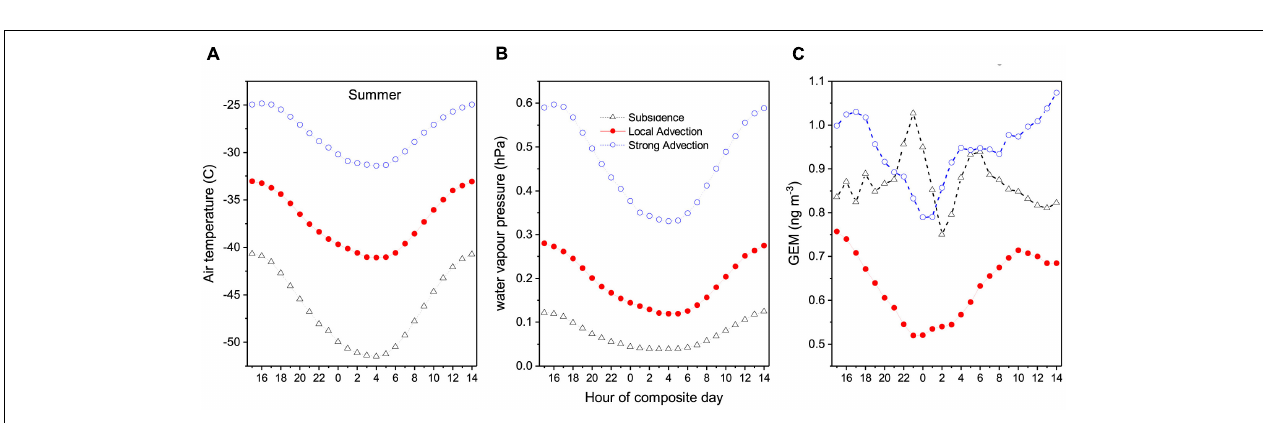
FIGURE 15 | (A,B) Summer diurnal composite distributions of hourly temperature and radon at DC for the three fetch classes, and (C,D) summer-winter comparison of diurnal composite distributions of ozone at DC for the three fetch classes in 2010.